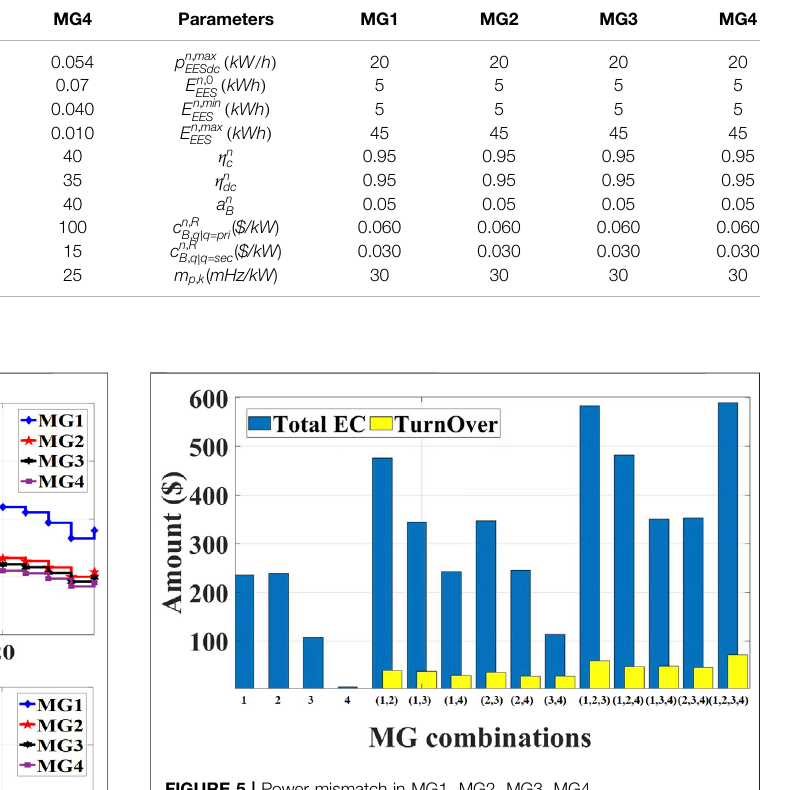
FIGURE 5 | Power mismatch in MG1, MG2, MG3, MG4.